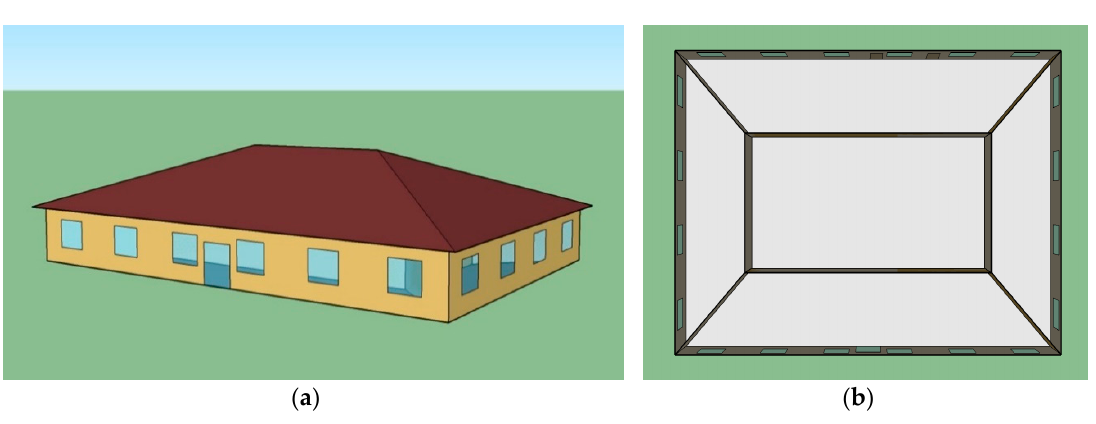
Figure 2. Case study ASHRAE standard model for small office building: ( a ) 3D view; ( b ) floor plan perspective view.